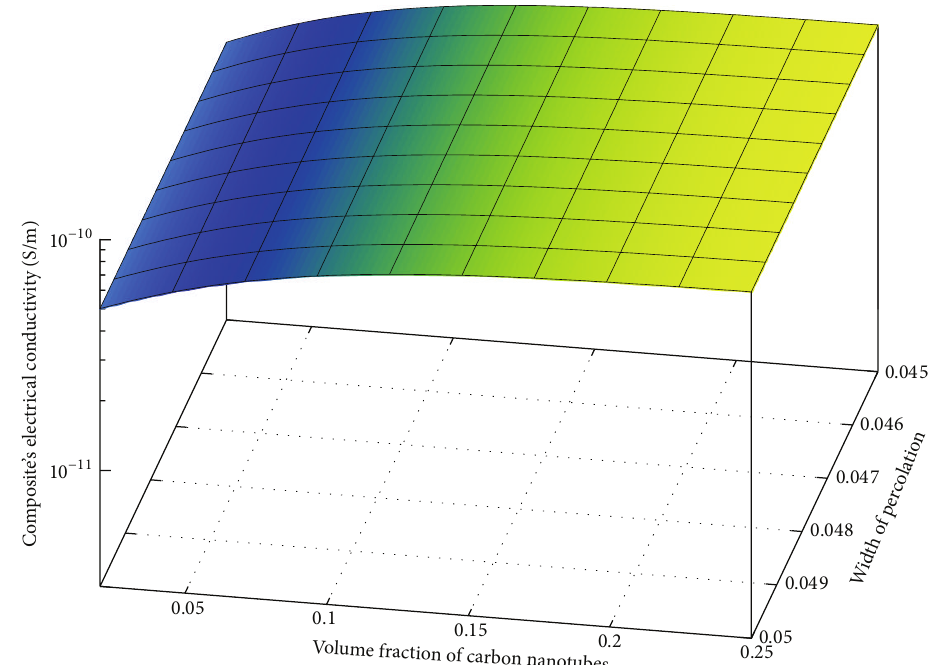
Figure 27: DC electrical conductivity of the nanocomposite at varying both the width of the percolation region and the volume fraction of the filler (Sigmoidal function